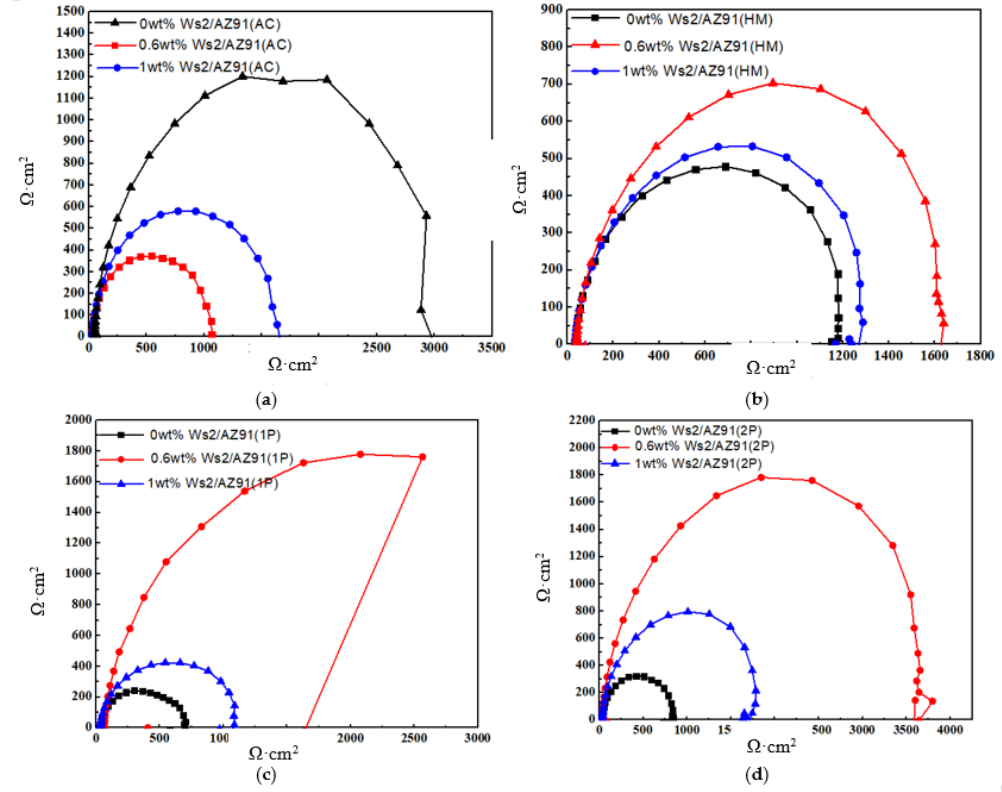
Figure 4. Nyquist plots for WS 2 /AZ91 composites in ( a ) as ‐ cast, ( b ) homogenized, ( c ) one ‐ pass ECAP, ( d ) two ‐ pass ECAP.